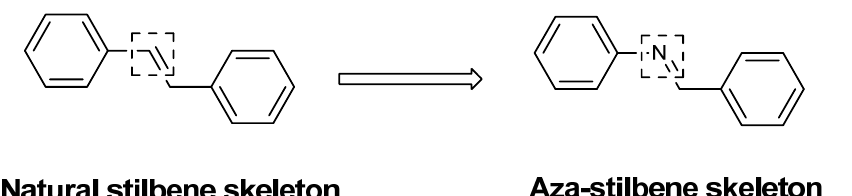
Figure 2. Comparison of the basic structures of natural and aza stilbene